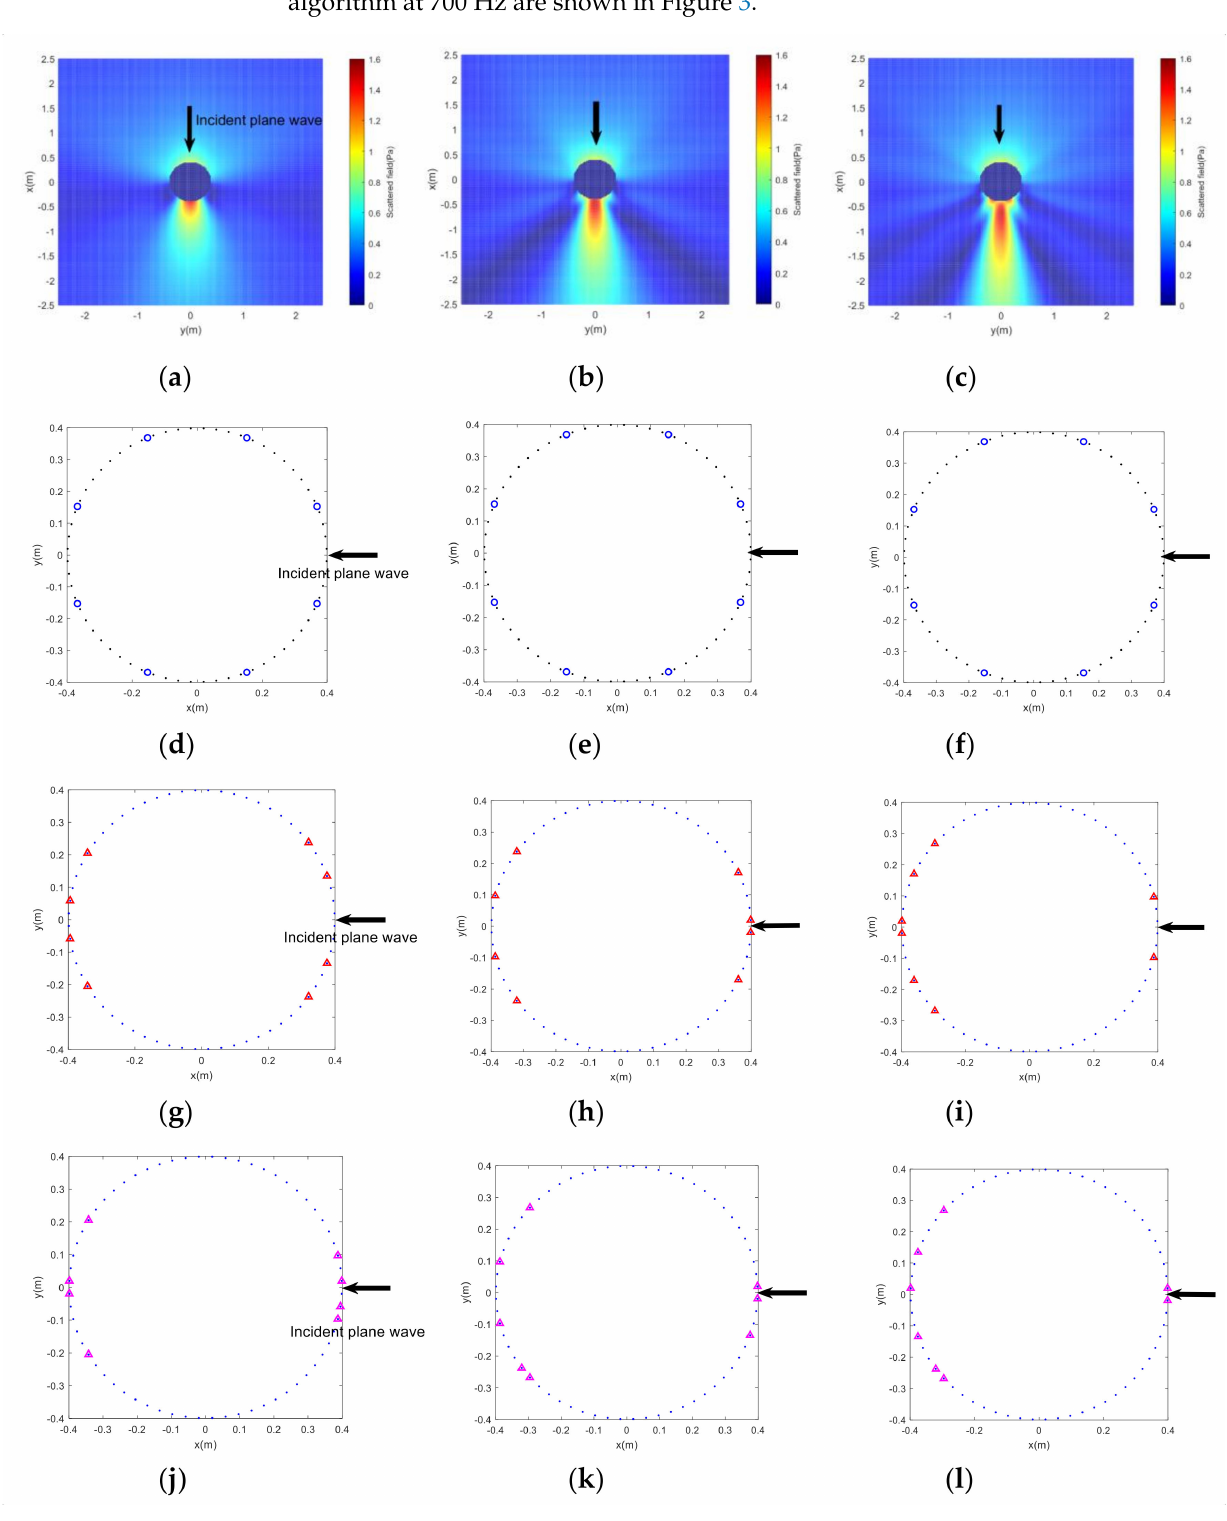
algorithm at 700 Hz are shown in Figure